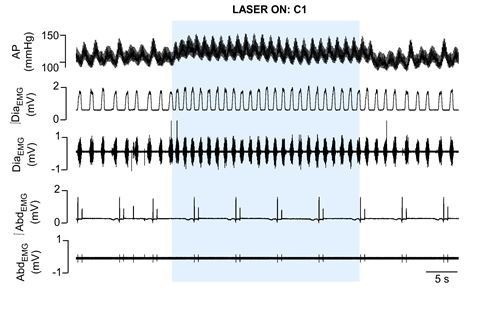
Cardiorespiratory effects elicited by optogenetic activation of C1 cells in urethane anaesthetized, vagotomized and artificially ventilated adult rats.The arterial pressure (AP); diaphragm electromyography activity (DiaEMG); and abdominal electromyography (AbdEMG) were measure before, during and after the 30 seconds of C1 photostimulation (474 nm blue laser).